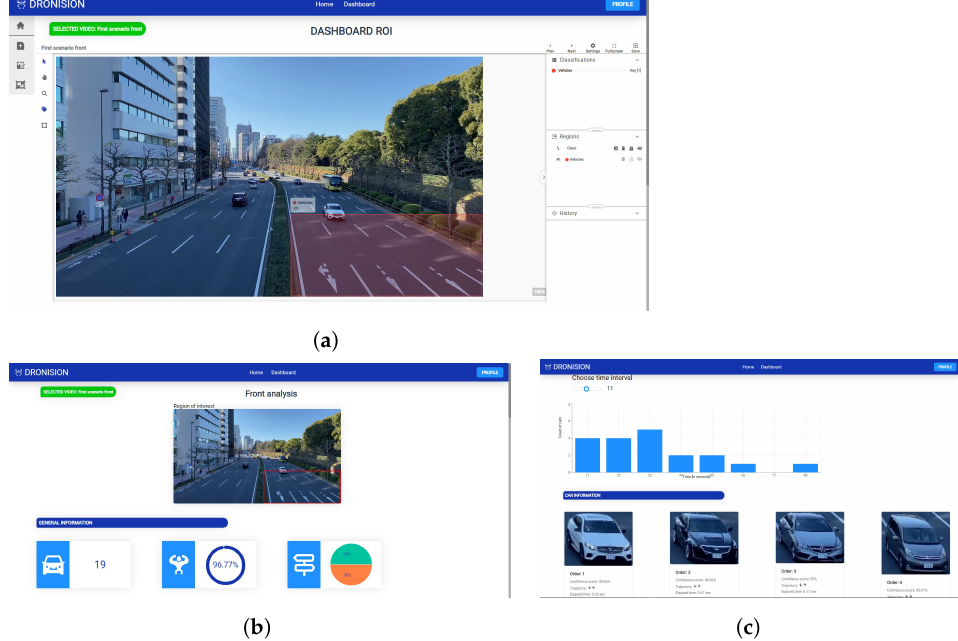
Figure 9. The user interface. ( a ) Region of interest section; ( b ) an analysis section; ( c ) an analysis